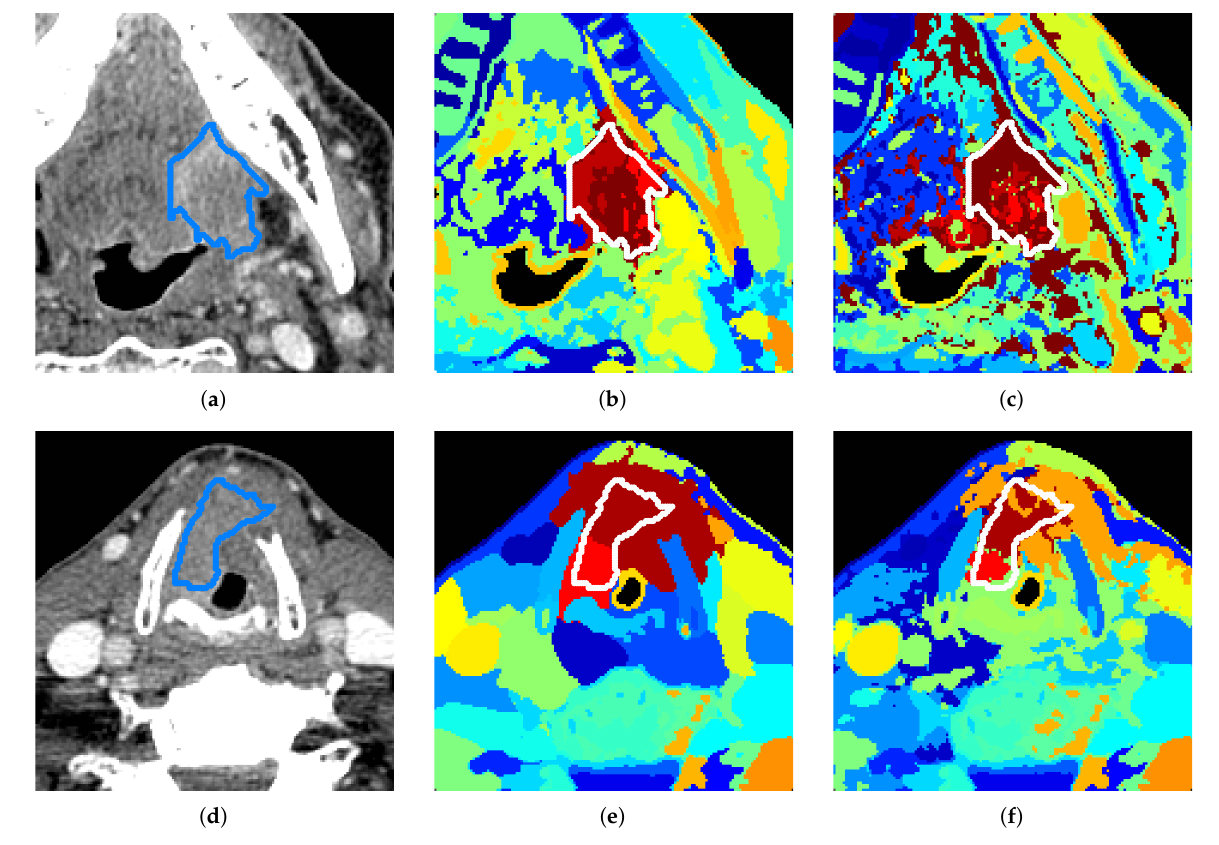
Figure 4. Clustering results for our SgMFR method with different λ tuning. ( a ) Original slice. ( b ) λ = 0 . 075 , Dice = 0.79, DB = 1.68/7.29, DB t = 1.47/6.79. ( c ) λ = 0 . 100 , Dice = 0.39, DB = 2.59/4.27, DB t = 3.34/3.74. ( d ) Original slice. ( e ) λ = 0 . 075 , Dice = 0.36, DB = 1.75/6.70, DB t = 1.28/23.71. ( f ) λ = 0 . 080 , Dice = 0.64, DB = 1.87/6.57, DB t = 1.78/2.93. One random color is assigned per cluster,